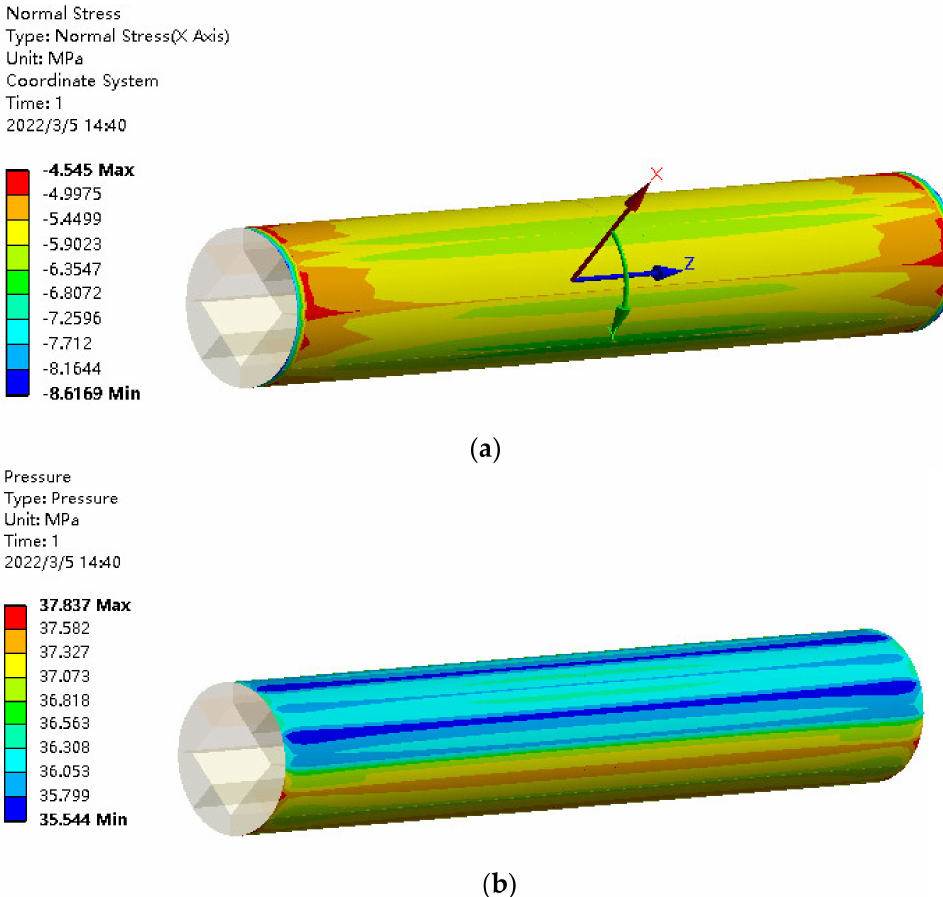
Figure 11. ( a ) Normal stress graph of contact interference. ( b ) Contact interference pressure result